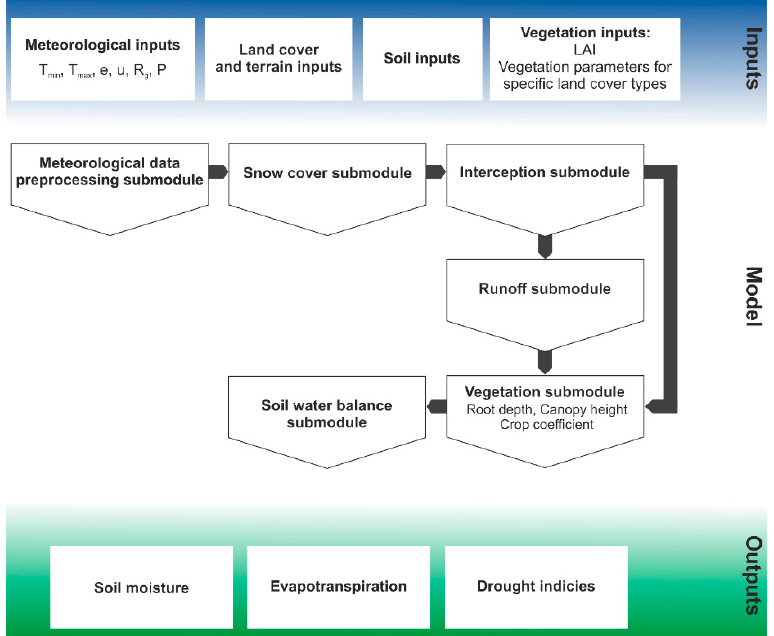
Figure 1. Basic scheme of the SoilClim model depicting the main model submodules. A detailed summary of the differences between the individual model setups appears in Table A1.